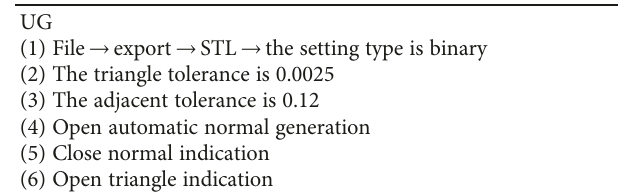
Table 4: The most optimized parameter setting method for converting the STL model.